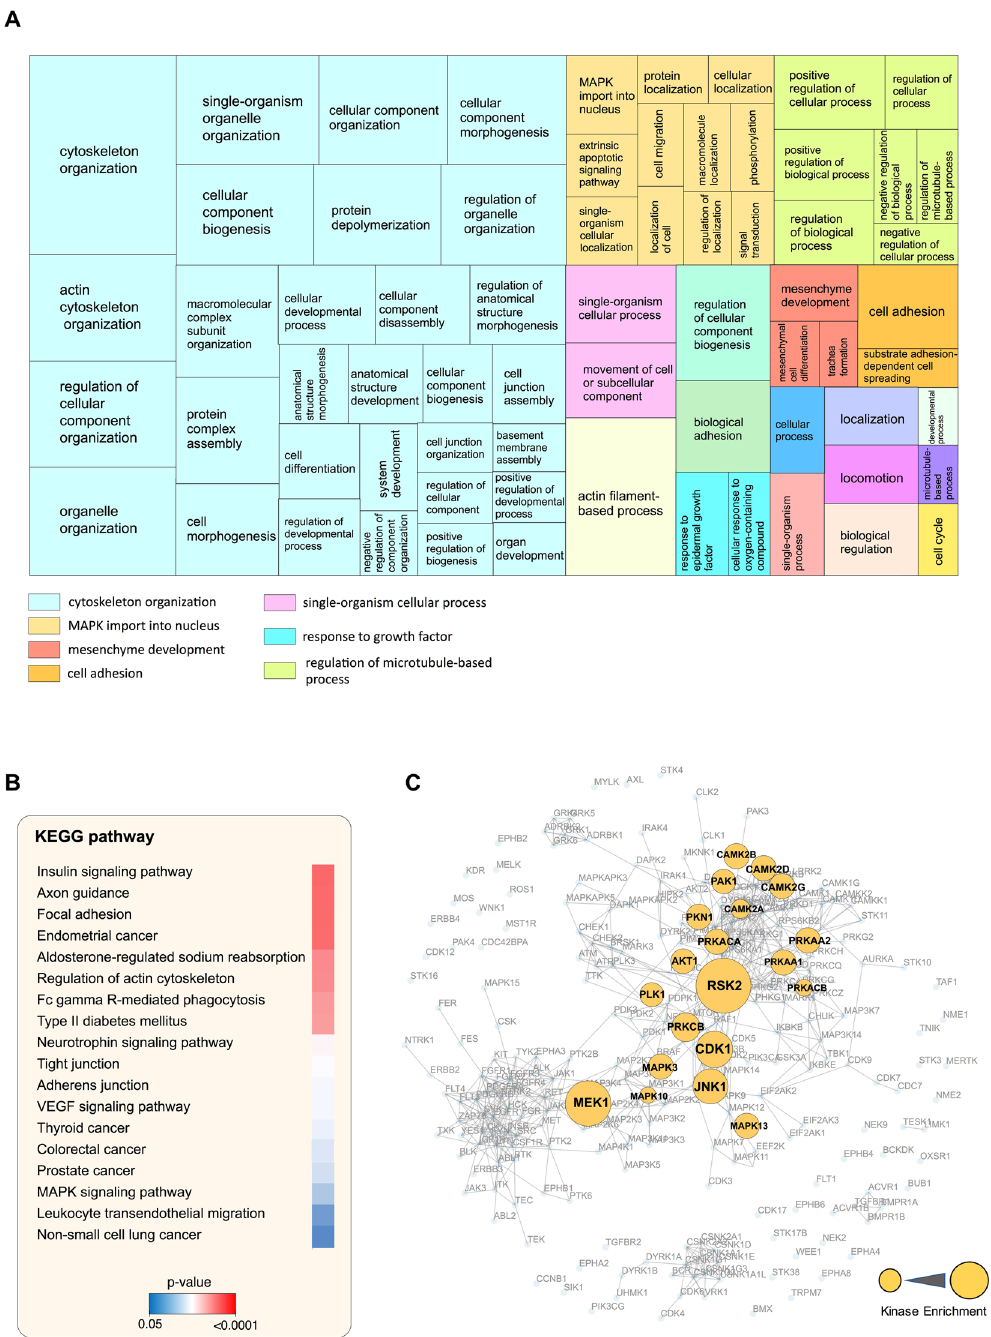
Figure 4. PDGF regulates distinct biological processes and signalling pathways. ( A ) Proteins containing the 161 PDGF regulated phosphosites were analysed in REVIGO to identify enriched GO Terms. Enriched biological processes are visualised as a Tree map. Clusters of related terms are displayed using the same colour and the size of the box corresponds to the − log10 p-value in that category. ( B ) Proteins containing the PDGF- regulated phosphosites were analysed in DAVID to identify enriched KEGG pathways. ( C ) PDGF-regulated phosphopeptides were searched using the Kinase enrichment analysis (KEA) tool. The network shows the enriched predicted upstream kinases and the node size corresponds to the number of PDGF-regulated phosphopeptides predicted to be phosphorylated by that